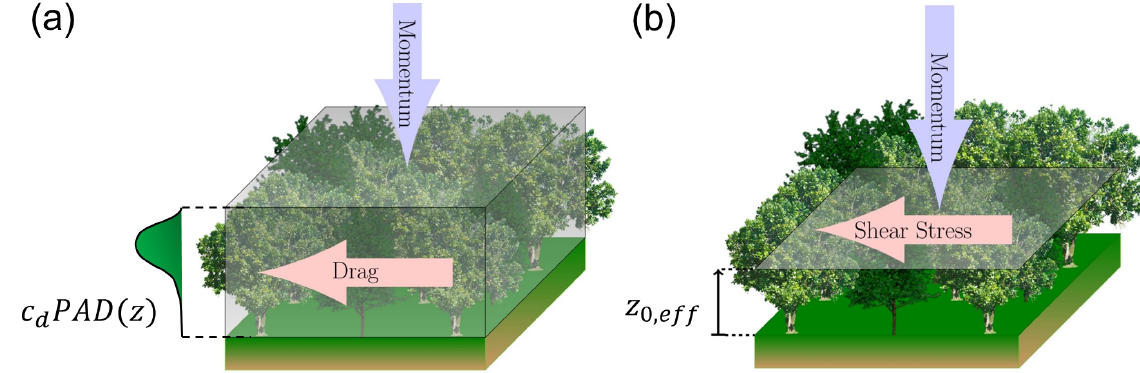
Figure 1. Schematic of principles behind (a) the drag force and (b) the roughness height (adapted from Boudreault,